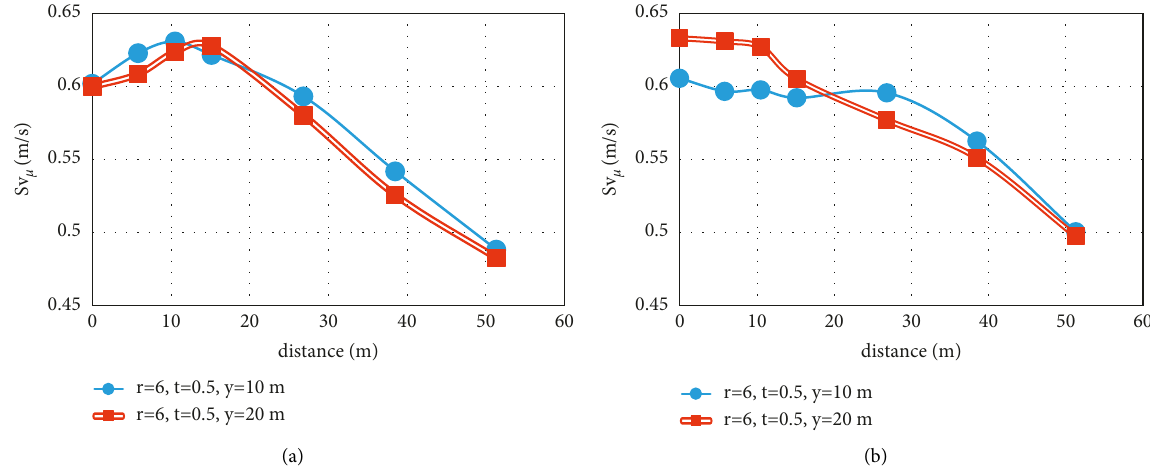
Figure 11: The effect of change in overburden depth on ground surface velocity for models (a) 18 and 19 and (b) 22 and 25 of Table